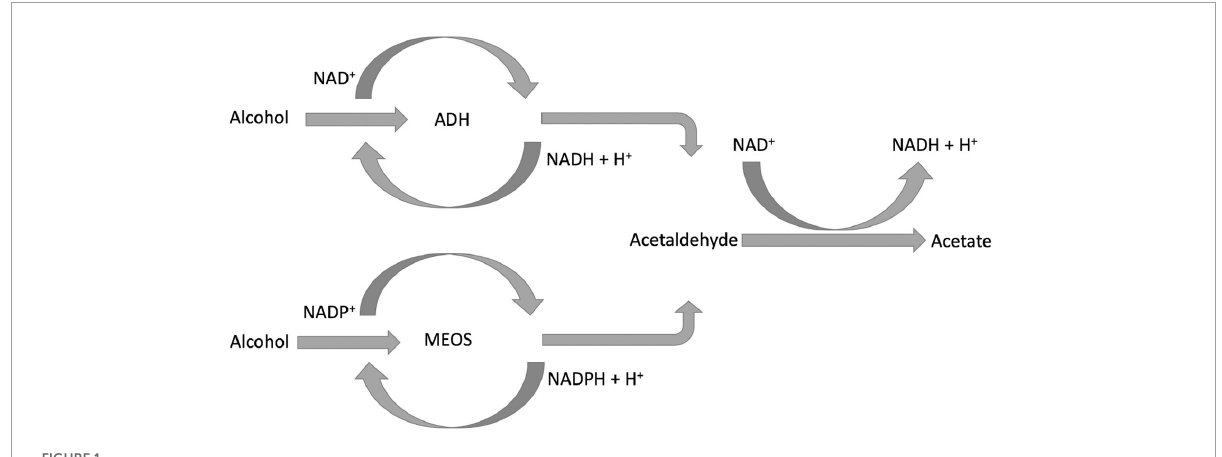
FIGURE1 Schematic demonstration of alcohol